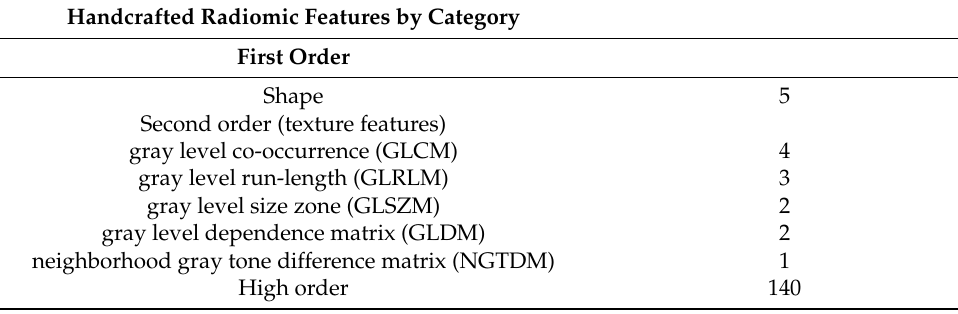
Table 3. Handcrafted radiomic features used in the second neural network model.